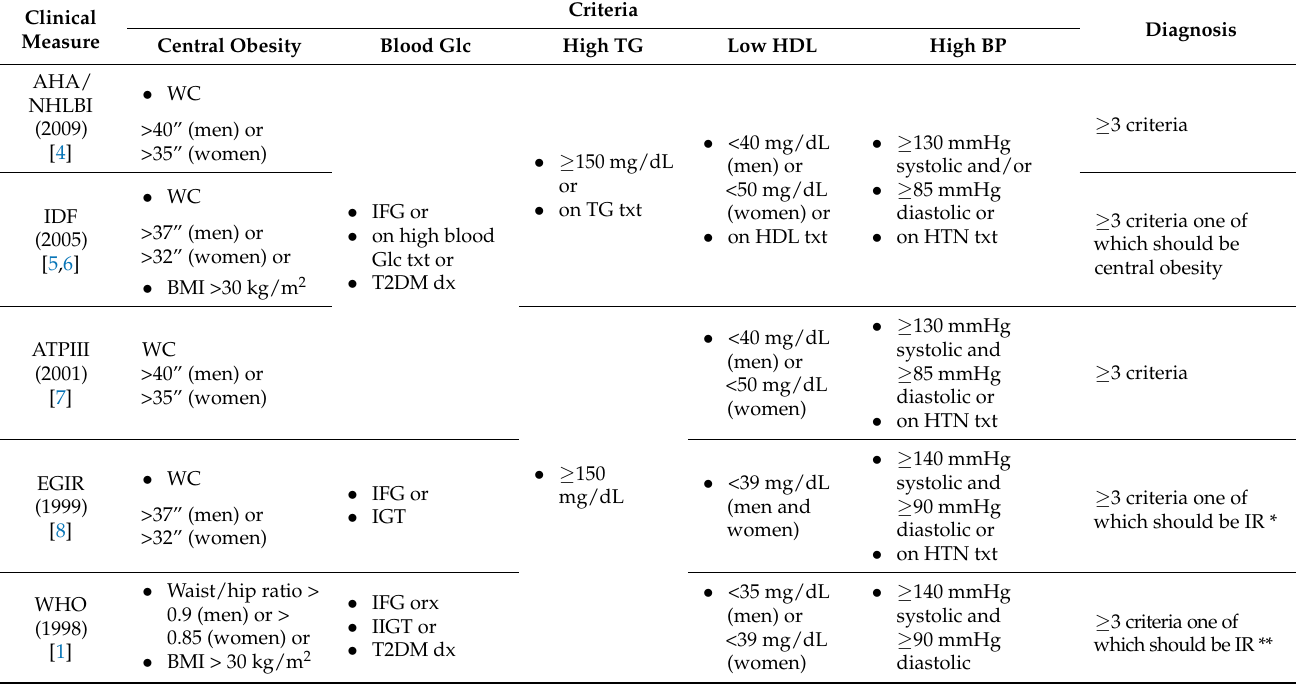
Table 1. Evolution of metabolic syndrome diagnostic definitions throughout the